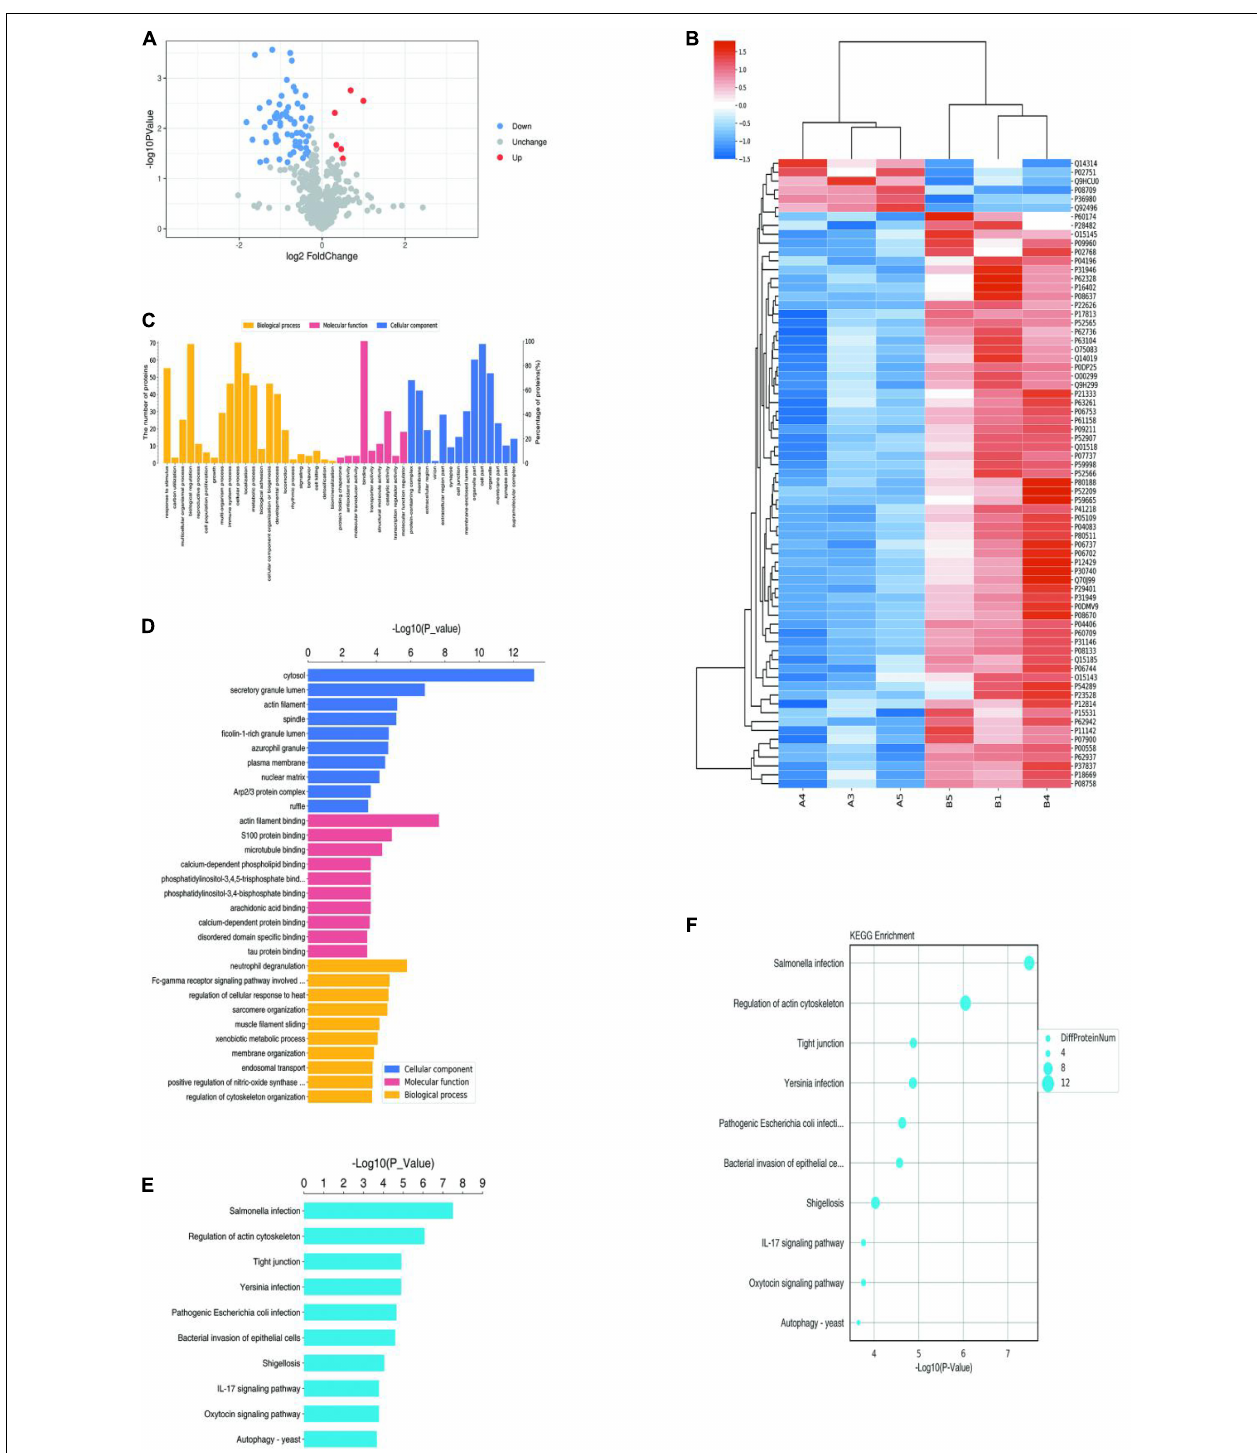
FIGURE 1 | Proteomics and bioinformatics analysis of proteins involved in VM. (A) Volcano plots for the differential expression of proteins between VM and the control group (Red—high expression; blue—low expression). (B) Heatmap for the differential expression of proteins between VM and control group (Red indicates high expression; blue indicates low expression). (C) Gene Ontology (GO) functional annotation analysis of differentially expressed proteins. (D) GO functional enrichment analysis of differentially expressed proteins. (E) KEGG functional enrichment analysis of differentially expressed proteins. (F) KEGG functional enrichment analysis bubble diagram of differentially expressed